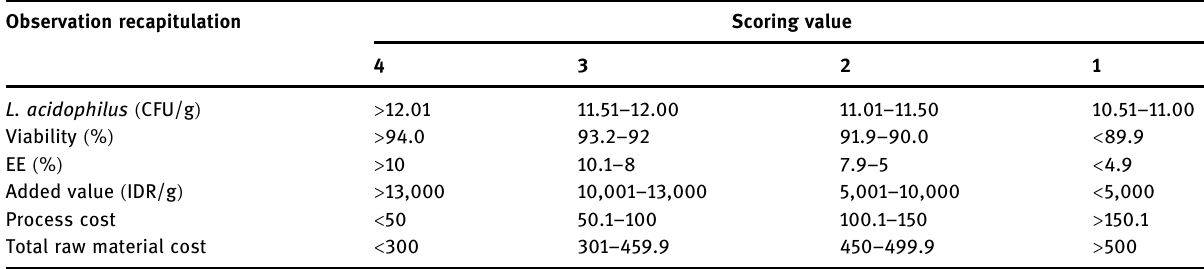
Table 1: The scoring value criteria of parameters observed Observation